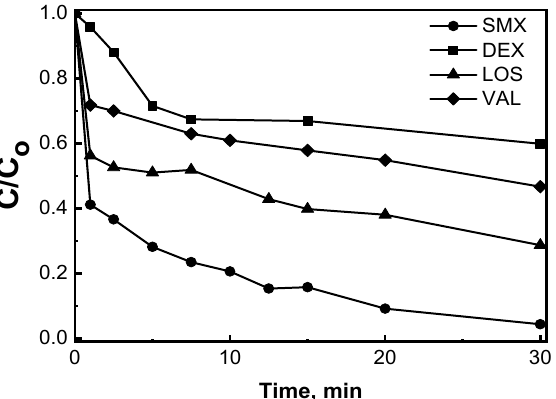
Figure 11. Degradation of 0.5 mg L − 1 of various pharmaceuticals with 100 mg L − 1 biochar and 250 mg L − 1 SPS in UPW and inherent pH.